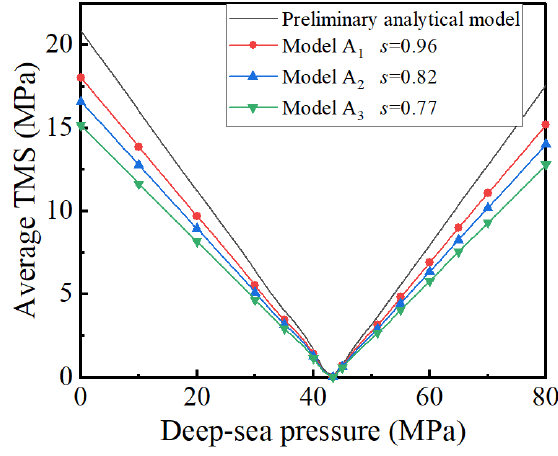
Figure 3. Average TMS of different slot shape factor variations with deep-sea pressure.